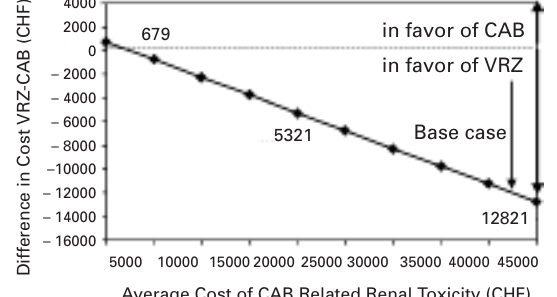
Figure 4 A. Sensitivity of cost difference due to costs related to acute renal failure: Cost as- sumptions regarding additional costs due to amphotericin B in- duced renal toxicity have been evaluated. Cost savings were calculated for voriconazole treat- ment over a wide range of cost esti- mates if larger than CHF 5000 per case of nephrotoxicity. VRZ = voriconazole, CAB = conventional amphotericin B; CHF = Swiss francs B. Sensitivity of inci- dence of acute renal failure on difference in total costs: Initial treatment with voriconazole became cost-saving for an in- cidence of acute renal failure >7%. VRZ = voriconazole, CAB = conventional amphotericin B; ARF = acute renal